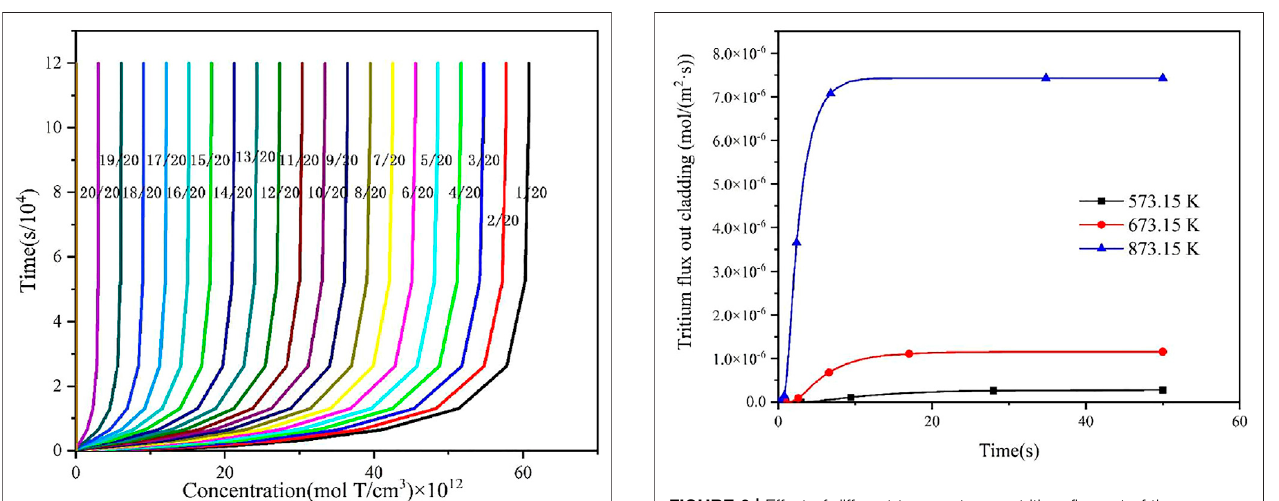
FIGURE 6 | Effect of different temperature on tritium fl ux out of the cladding outer